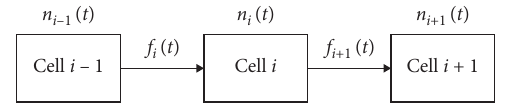
Figure 2: Schematic diagram of the basic road link of the CTM.